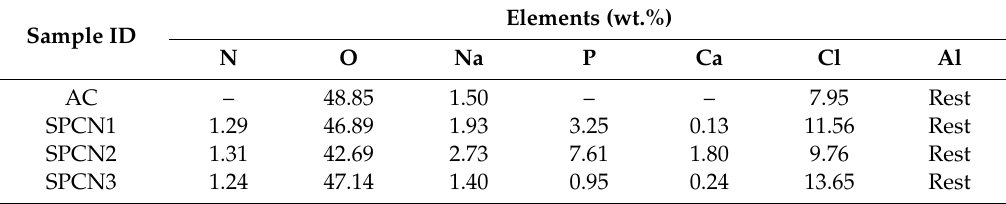
Table 5. EDS analysis of coatings after 89 days of exposure in 3.5 wt.% NaCl solution.